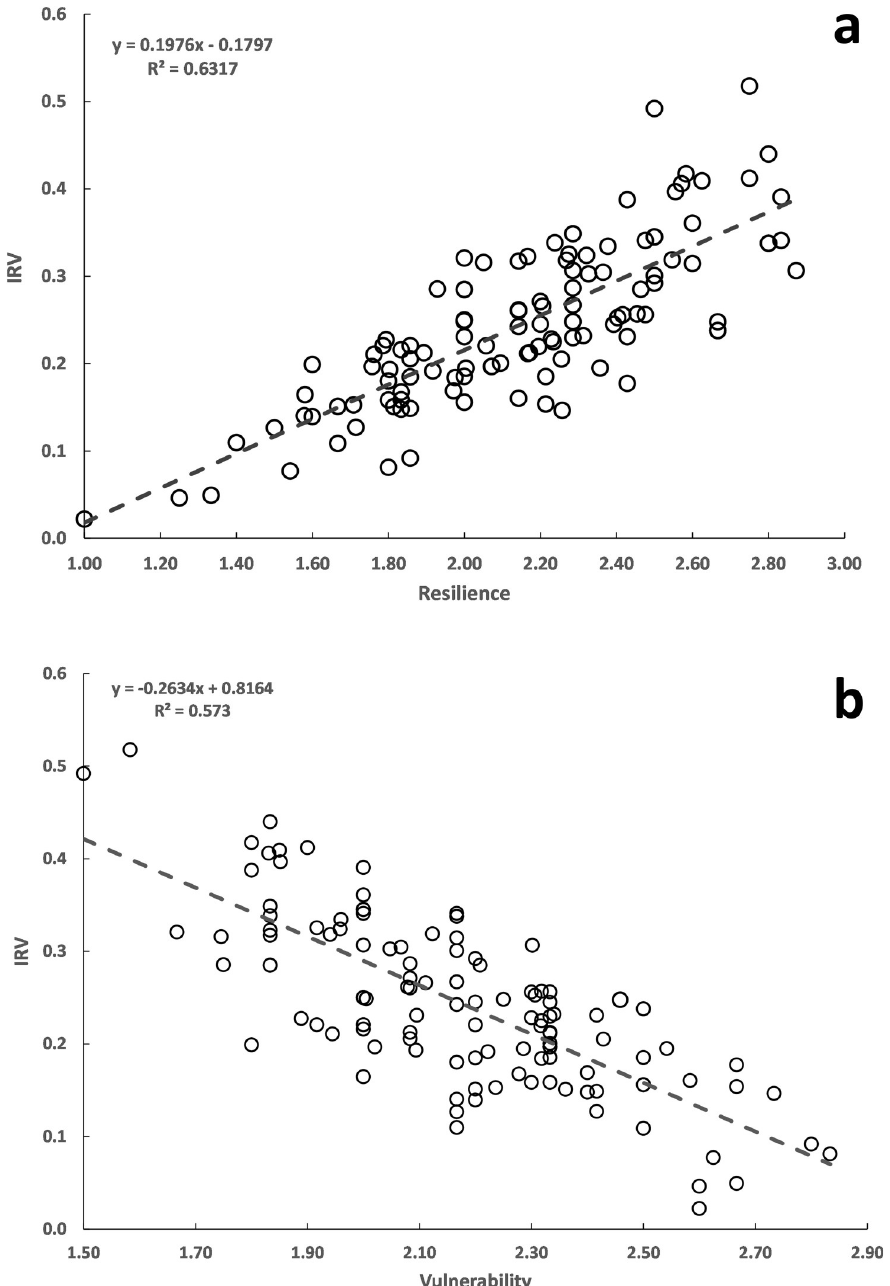
Fig 6. Relationship between resilience score and IRV (a) and relationship between vulnerability score and IRV (b); n = 133 species. over a long period from a tropical region; (ii) identify gaps in data availability of a few impor- tant species or data-deficient species that are not represented in this analysis; and (iii) prioritise biological research needs to inform management and conservation of tropical fishes in the coming decades. As the source of data for the analysis is largely from commercial landings, it can be taken that the majority of the species covered in this paper contribute to fisheries.